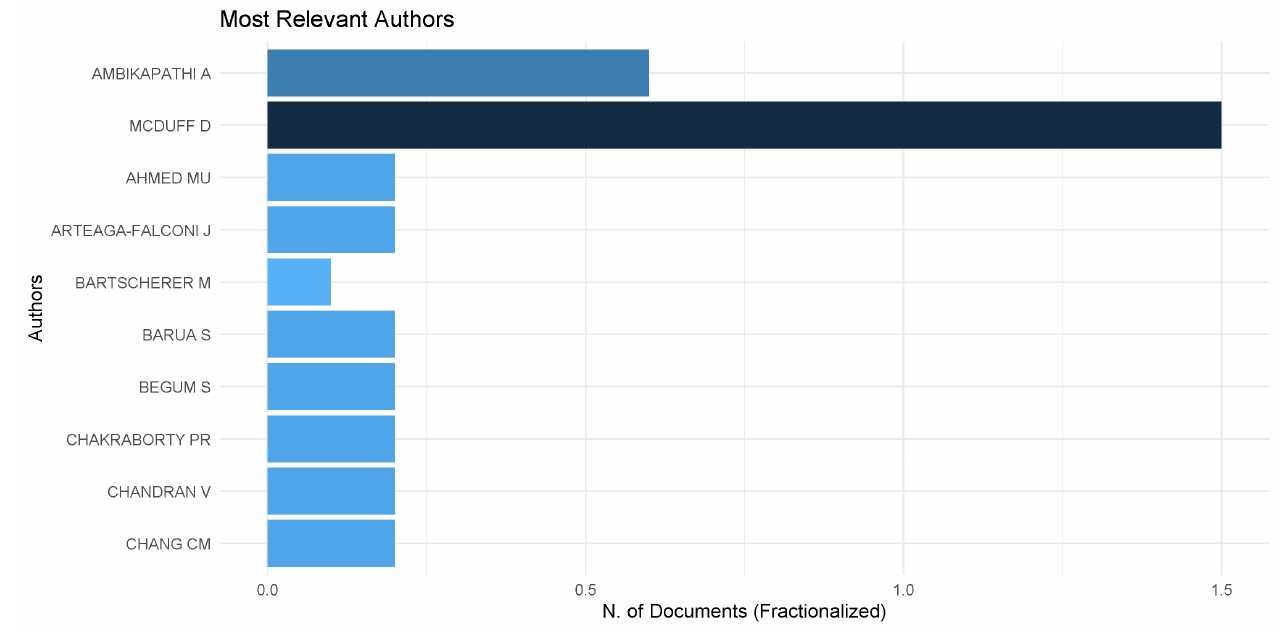
Figure 5. Impact of authors.